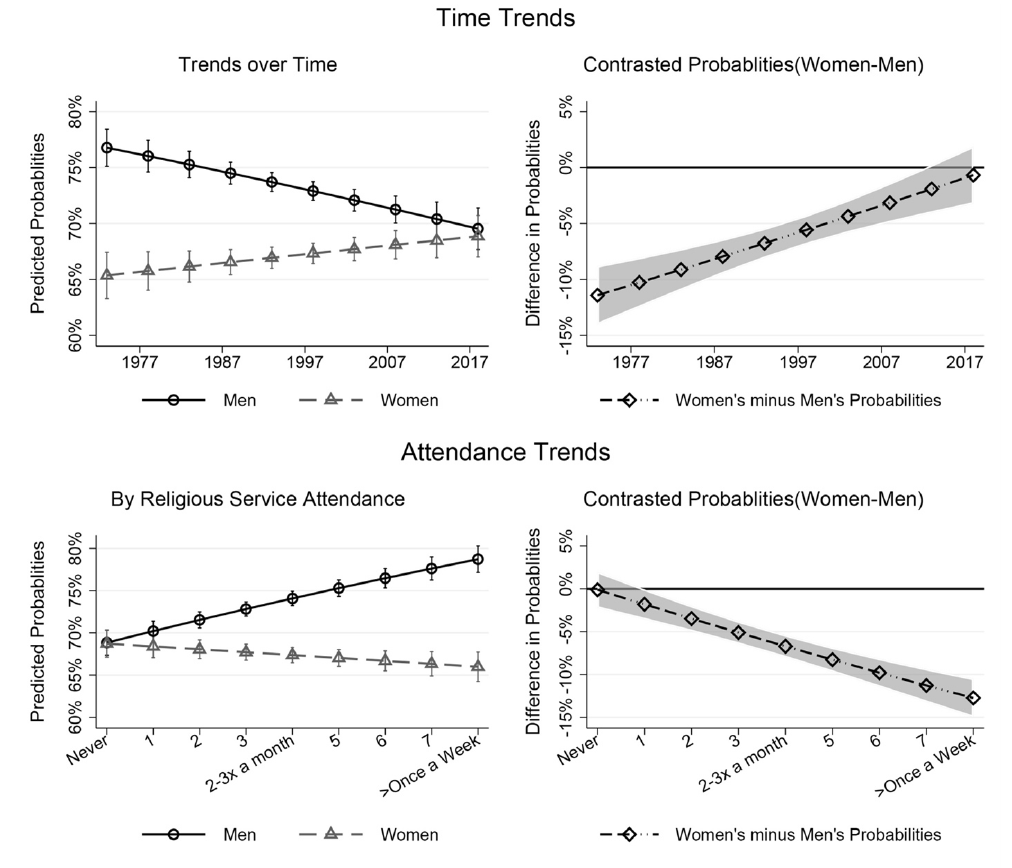
Figure 1: Gender differences in willingness to work when not financially necessary by time and religious service attendance with relative difference plots. Source: General Social Survey, 1977 to 2018. Linear best fit trend line. Models underlying predicted probabilities parallel those in Table 1. They include the following controls: religious affiliation, happiness, full-time work status, job satisfaction, equivalized family income, marital status, number of children, education, age, race, whether born in the United States, region, and whether respondent lives in a city. Full models presented in the online supplement. When examining year, the underlying model controls for attendance. When examining attendance, the underlying model controls for